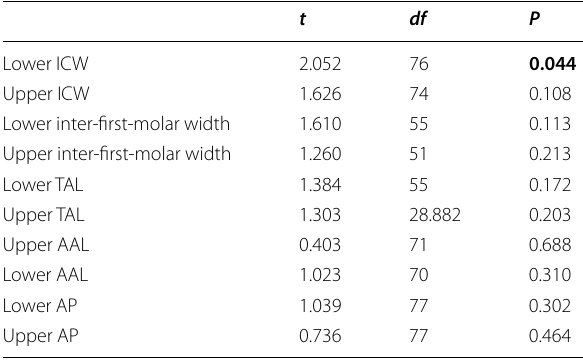
Table 4 Showing t test for equality of Means for the two genders